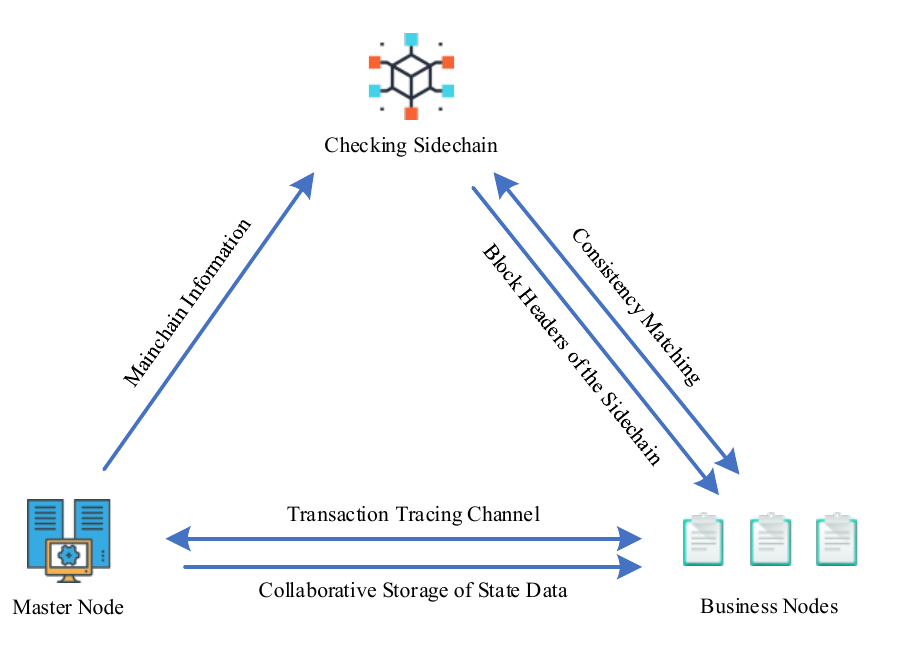
Figure 2. System